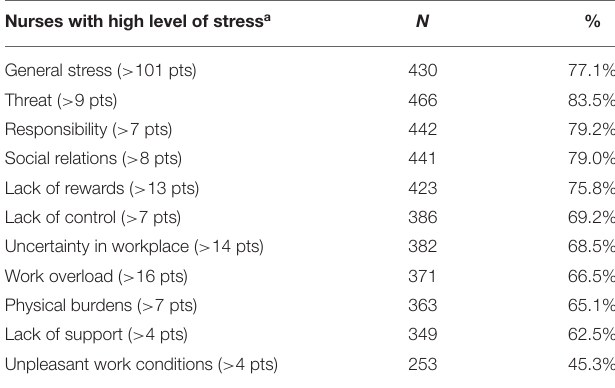
TABLE 4 | Number and percentage of nurses with high levels of negative work